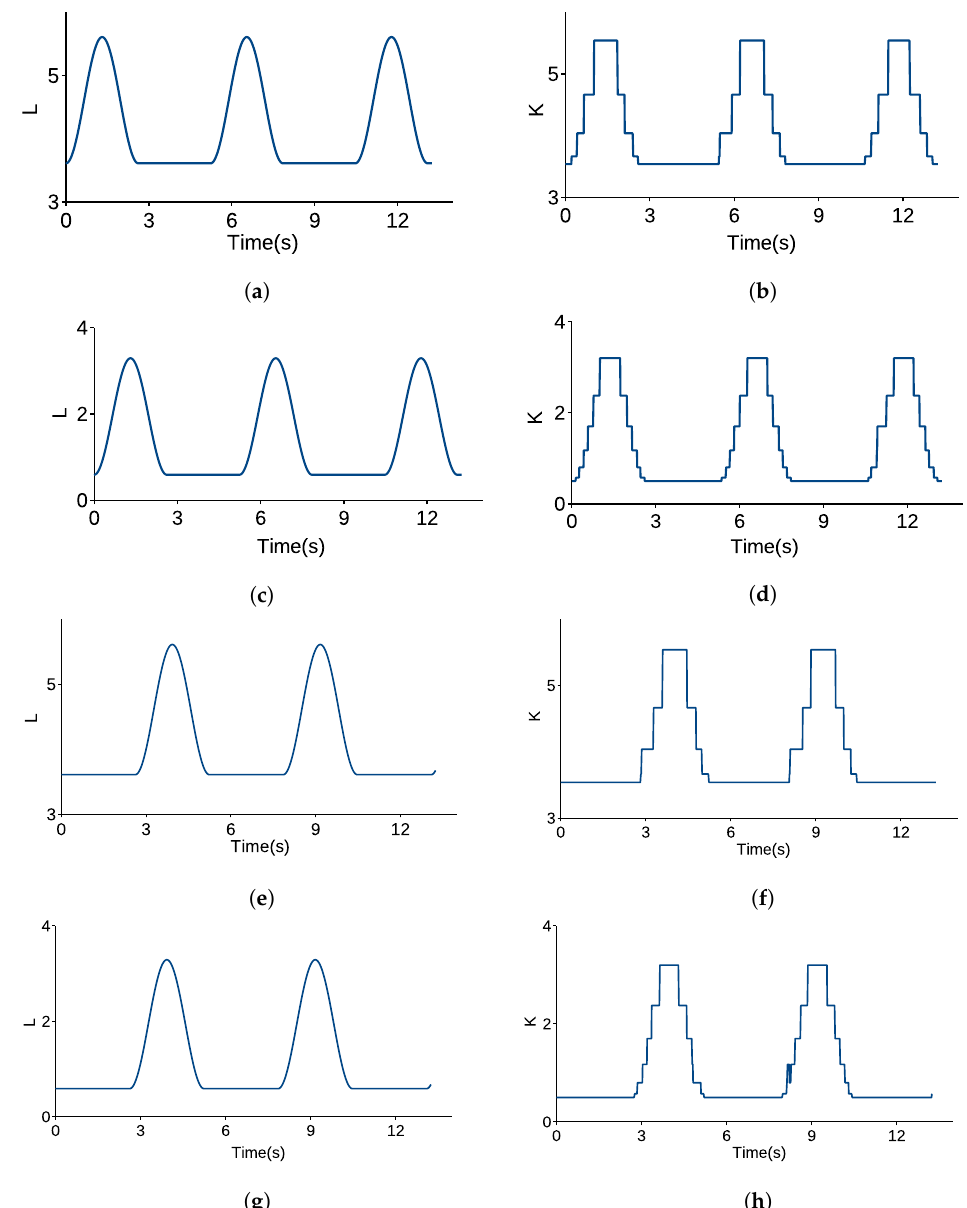
Figure 9. Changes of L and K parameters for left hip, left knee, right hip, and right knee: ( a ) L for left hip, ( b ) K for left hip, ( c ) L for left knee, ( d ) K for left knee, ( e ) L for right hip, ( f ) K for right hip, ( g ) L for right knee, ( h ) K for right